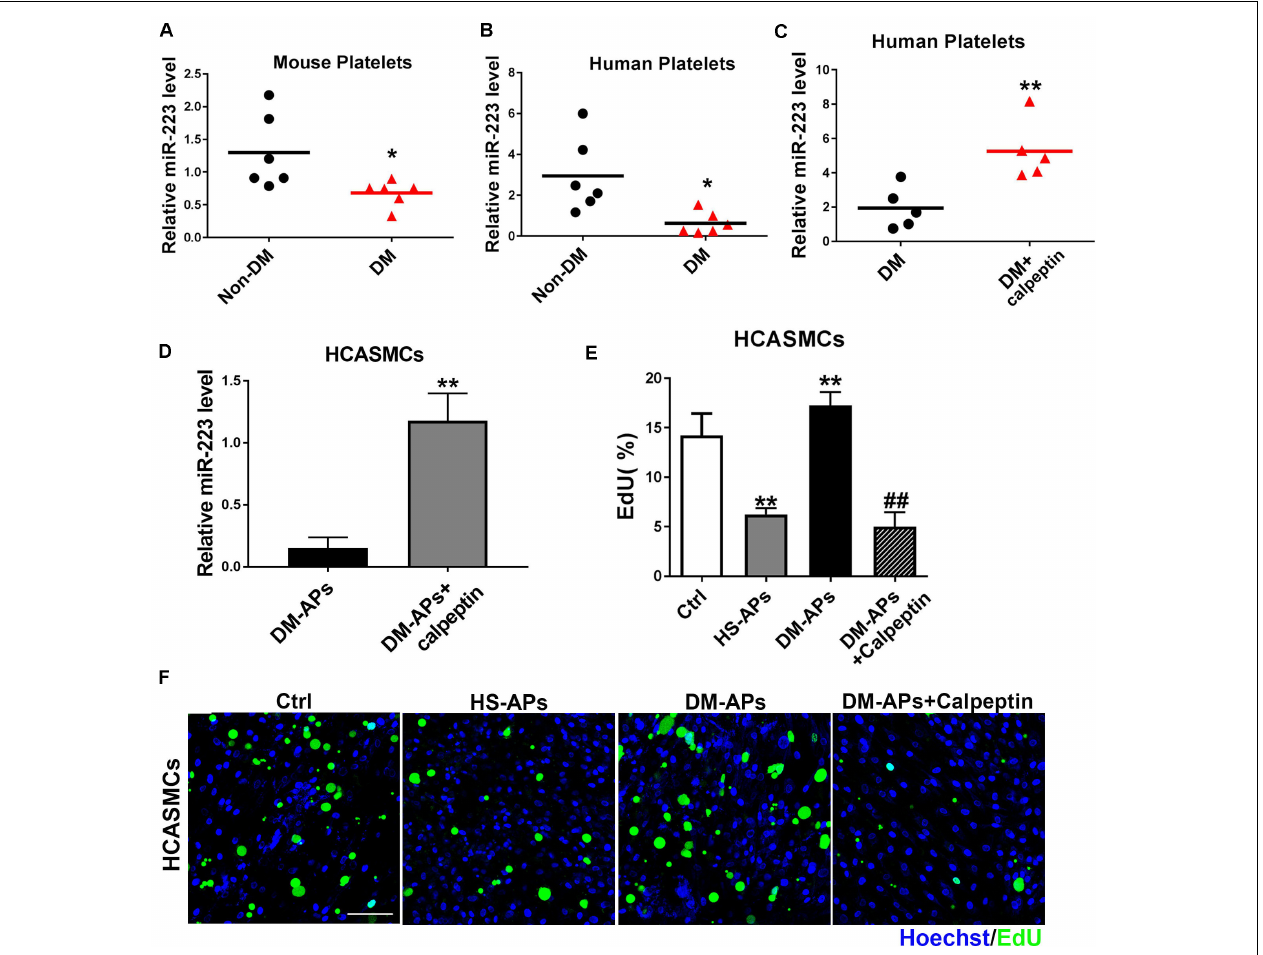
FIGURE 5 | Treatment of a calpeptin restored the expression of miR-223 in diabetic platelets. (A,B) The miR-223 level in mouse and human platelets was detected by qRT-PCR assays. Data are presented as mean ± SD ( n = 6). Comparisons between two groups were analyzed using unpaired nonparametric Student’s t -test. * P < 0.05 vs Non-DM. (C,D) Diabetic platelets were treated with a calpeptin for 24 h in vitro. The expression of miR-223 in human platelets and HCASMCs was detected by qRT-PCR assays. Data are presented as mean ± SD ( n = 6). Comparisons between two groups were analyzed using unpaired nonparametric Student’s t -test. ** P < 0.01 vs DM. (E,F) The rate of proliferation was determined by EdU incorporation assay in VSMCs treated with calpeptin. Data are presented as mean ± SD ( n = 6). Comparisons between more than two groups were analyzed using one-way ANOVA analysis with the Dunnett’s multiple correction. ** P < 0.01 vs Ctrl (VSMCs without platelets); ## P < 0.01 vs